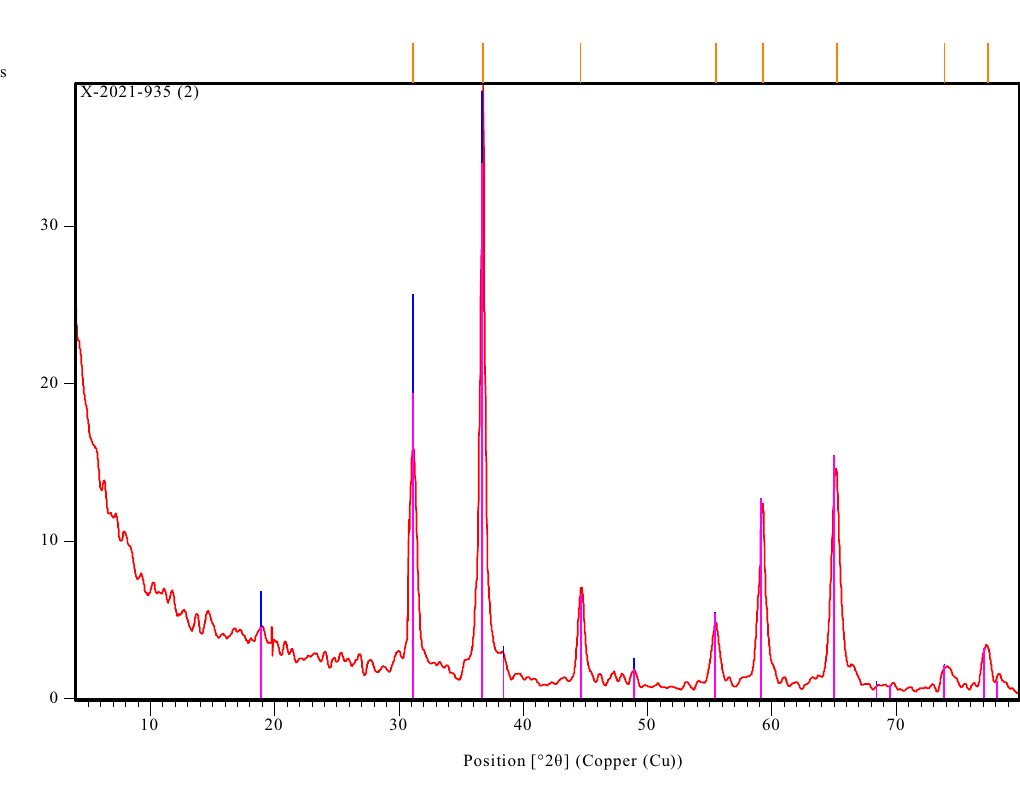
Figure 4. EDX Spectrum of The Parent Nano CoAl 2 O 4 Catalyst.